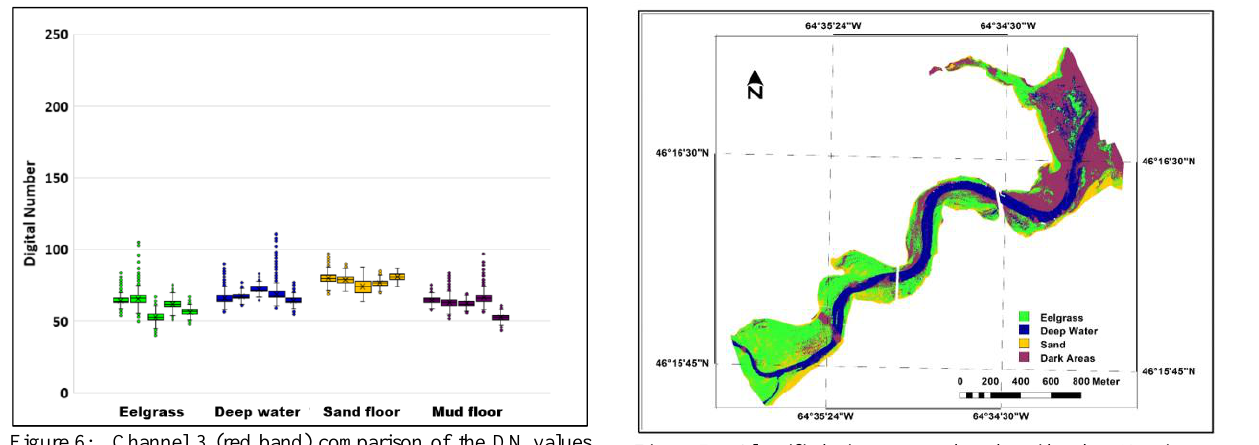
Figure 7. Classified image produced with the Maximum Likelihood Classifier (MLC) applied to the Pix4D® RGB mosaic of Shediac Bay.